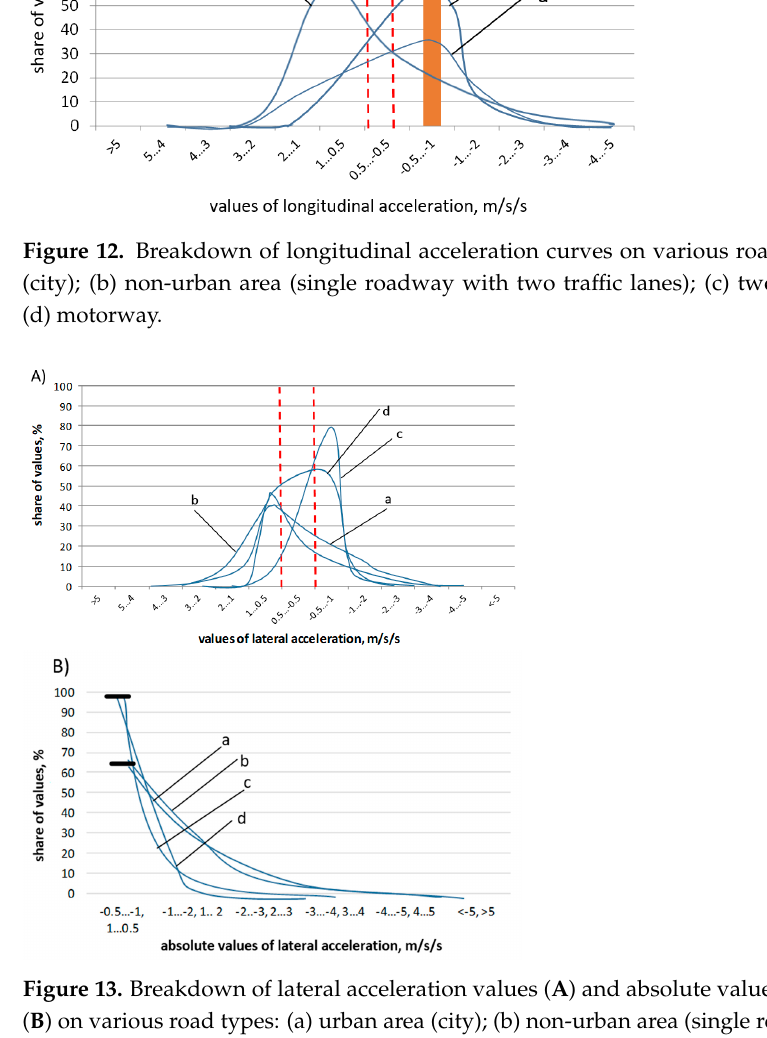
Figure 13. Breakdown of lateral acceleration values (A) and absolute values of lateral acceleration (B) on various road types: (a) urban area (city); (b) non-urban area (single roadway with two traffic lanes); (c) two-roadway expressway; (d) motorway.